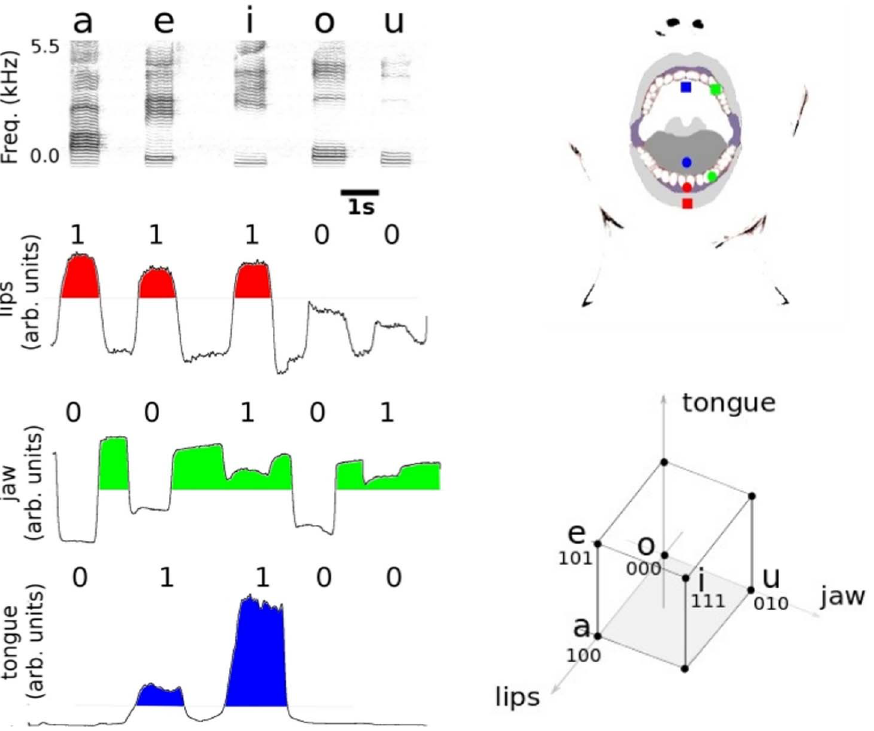
Figure 1. From transducer signals to binary vowel space. Upper right panel: sketch of Hall Effect transducers and magnets in the oral cavity. Transducers are marked with squares and magnets with circles. Lips (red): the transducer was attached to the center of the lower lip and the magnet was glued to the dental plastic replica, in between the central incisors. Jaw (green): magnet and transducer were glued to the dental replicas, in the space between the canine and the first premolar of the upper and lower teeth respectively. Tongue (blue): a cylindrical magnet was attached at a distance of 1.5 cm from the tip of the tongue. The corresponding Hall Effect transducer was glued to the dental plastic replica, at the hard palate, 1 cm right over the superior teeth (sagittal plane). Transducer wire was glued to the plastic replica and routed away to allow free mouth movements. Left, downwards: a spectrogram of the set of 5 vowels as pronounced by one of the subjects during a recording session (and frequency values for the first 2 formants) and the corresponding transducer signals for the lips, jaw and tongue. A binary code for each vowel can be defined by labeling the signal of each articulator as active (1) or inactive (0) as it reaches or not a predefined threshold (areas in color correspond to active motor coordinates). Lower right panel: resulting vowel-cube in the binary space. The edges of the cube represent an abstract space of size 8, were we explicitly locate the 5 vowels used in this work. mance for a dataset obtained from a population of different